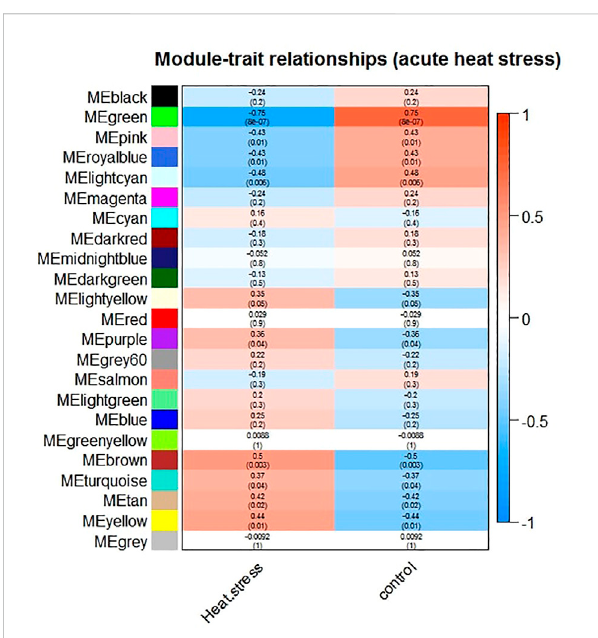
FIGURE 5 Module-trait relationships between the identi fi ed modules and treatment groups (acute heat treated versus non-treated control groups). The correlation between the traits and the module eigengenes was used for the calculation of the relationship. The red color indicate strong positive correlation while the blue color indicate strong negative correlation. Rows represent module eigengene and columns represent the treatment groups. The fi rst row within each cell represent the correlation and the second one represent the signi fi cance level ( p